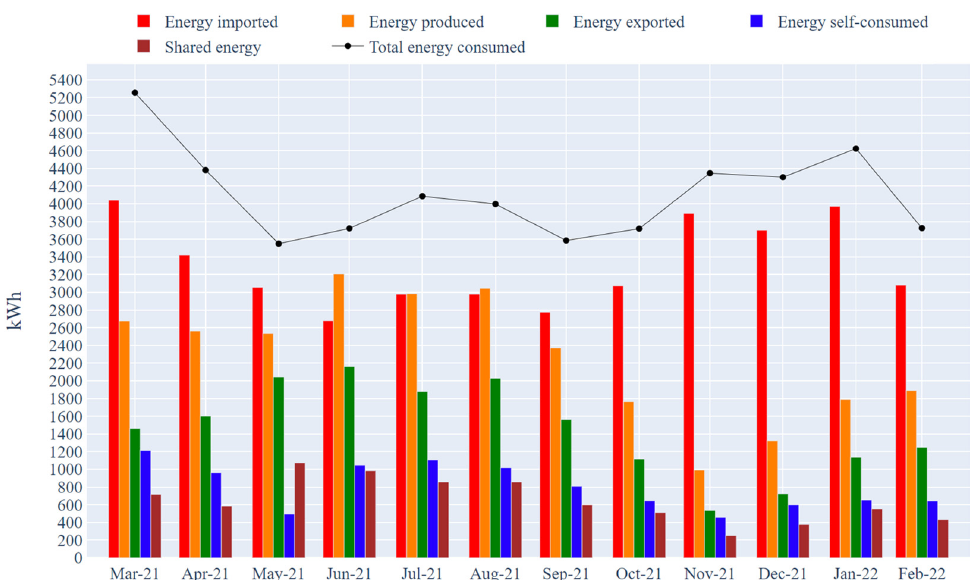
Figure 6. Monthly details about energy imported, exported, produced, and self-consumed, and total energy consumption.